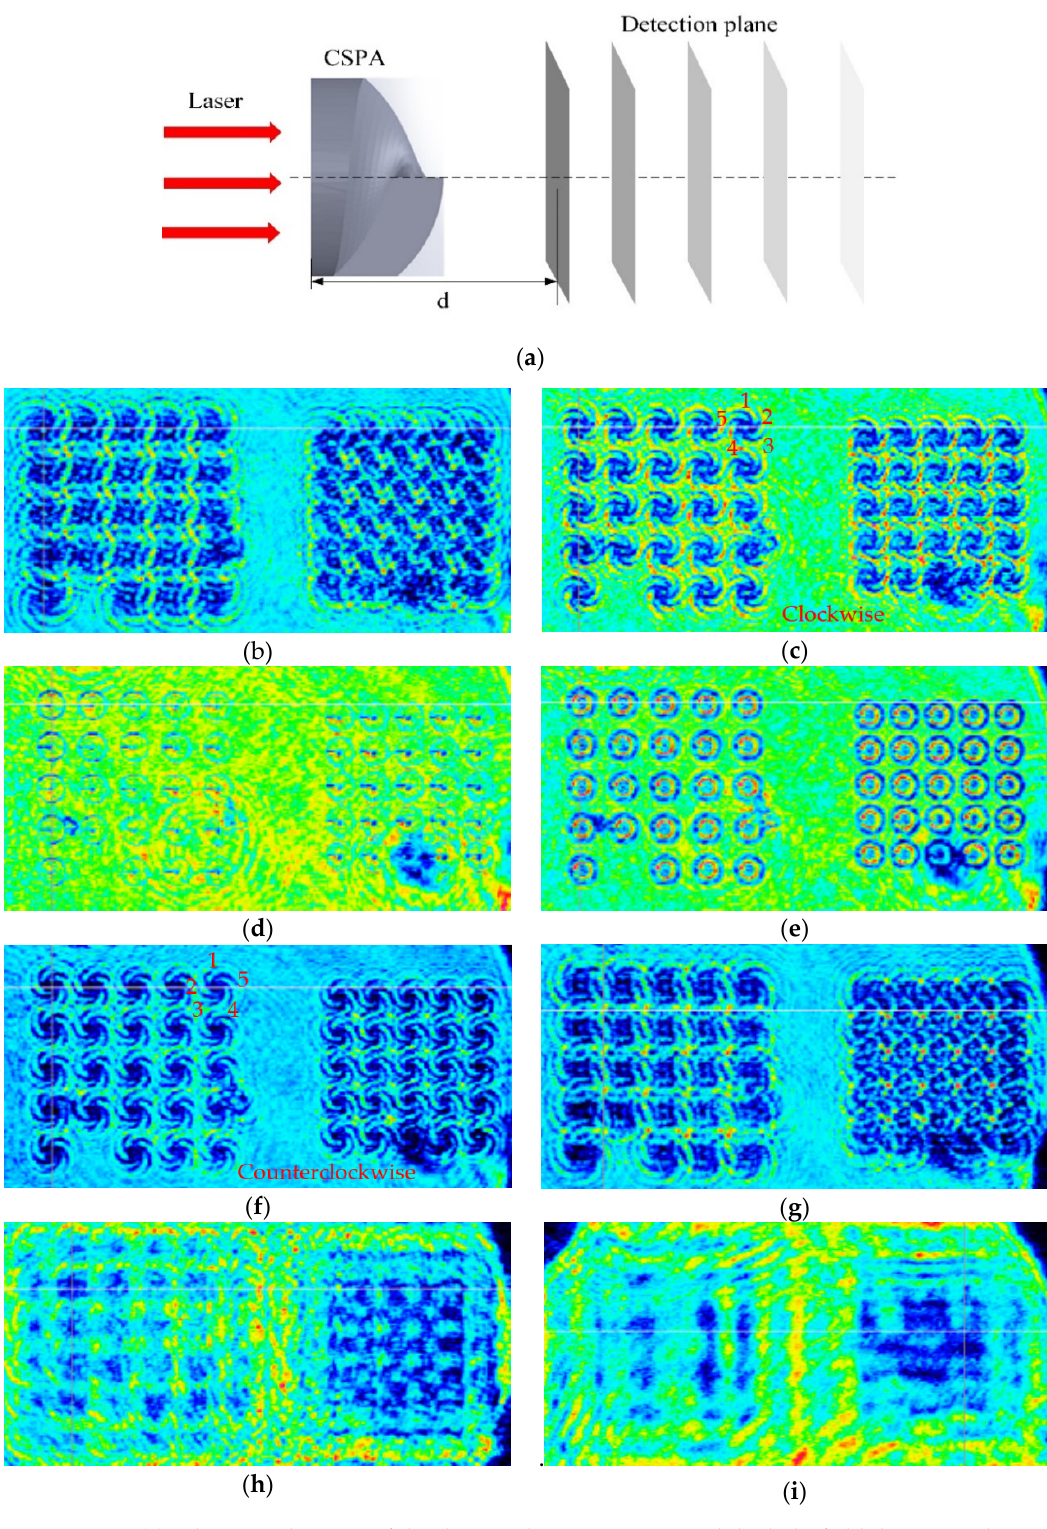
Figure 10. ( a ) Schematic diagram of the distance between CASP and the light field detection plane. The light intensity distribution of a center wavelength in the range of 635–671 nm laser beams, when the distance d is: ( b ) 200 µ m, ( c ) 300 µ m, ( d ) 380 µ m, ( e ) 400 µ m, ( f ) 500 µ m, ( g ) 600 µ m, ( h ) 3000 µ m, and ( i ) 10,000 µ m, respectively.